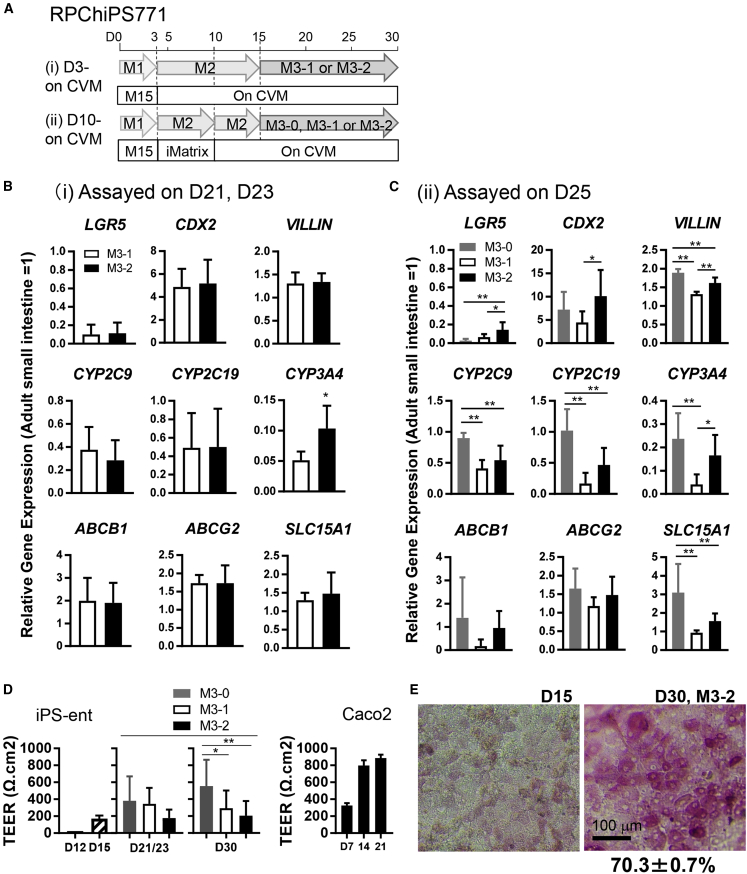
Alternative Maturation Procedure to Generate hiPS-derived Enterocyte-Like Cells(A) A schematic drawing of the experimental design.(B and C) The expression of differentiation markers, transporters, and metabolizing enzymes in RPChiPS771-derived enterocyte-like cells cultured under protocol (i) assayed on day 21 or 23 (D21, D23) (B) or protocol (ii) assayed on day 25 (D25) (C) are shown.(D) TEER values of iPS-derived enterocyte-like cells cultured under protocol (ii) (left) or Caco-2 cells (right).(E) The activity staining of ALP was performed with RPChiPS771-derived enterocyte-like cells on D15 and D30.Data are expressed as the mean ± SD (n = 3; n, independent experiments). Relative values versus those of the adult intestine (=1) are shown (B, C). Differences between groups were analyzed by Student’s t test (B), or one-way ANOVA Tukey's multiple comparisons test (C, D), ∗p < 0.05, ∗∗p < 0.01. Scale bar, 100 μm.